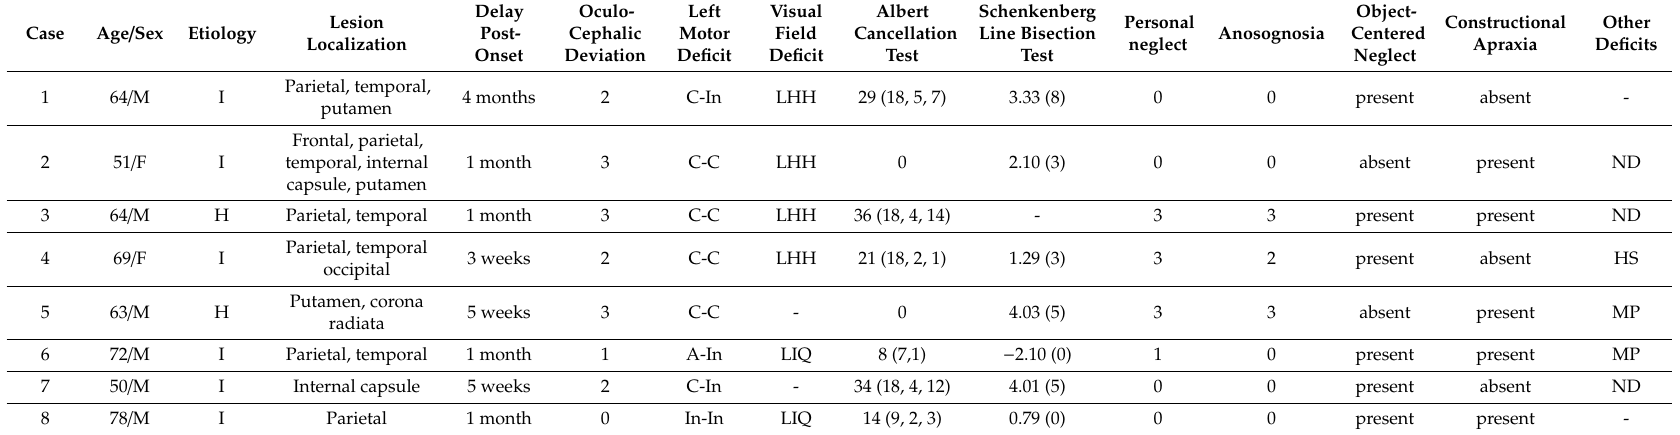
Table 2. Demographic, lesion and neglect assessment data for left unilateral neglect (RBD + ) patients: oculocephalic deviation (GEREN scale [22]), motor deficit assessed by clinical examination (upper-limb–lower-limb), visual field deficit assessed by visual campimetry, peripersonal neglect assessed by the Albert cancellation test [19] (number of omissions / 40 (Left omissions, Middle omissions, Right omissions)) and the Schenkenberg line bisection test [20] (mean deviation in cm (number of omissions)), personal neglect (Bisiach score [21]), anosognosia (Bisiach score [23]), object centered neglect assessed by drawing a flower and a butterfly from memory, constructional apraxia assessed by drawing from memory and copying a cube. Other deficits were neglect dyslexia (reading a text), hyperschematia (previous drawing from memory) and motor perseveration on cancellation test and drawing from